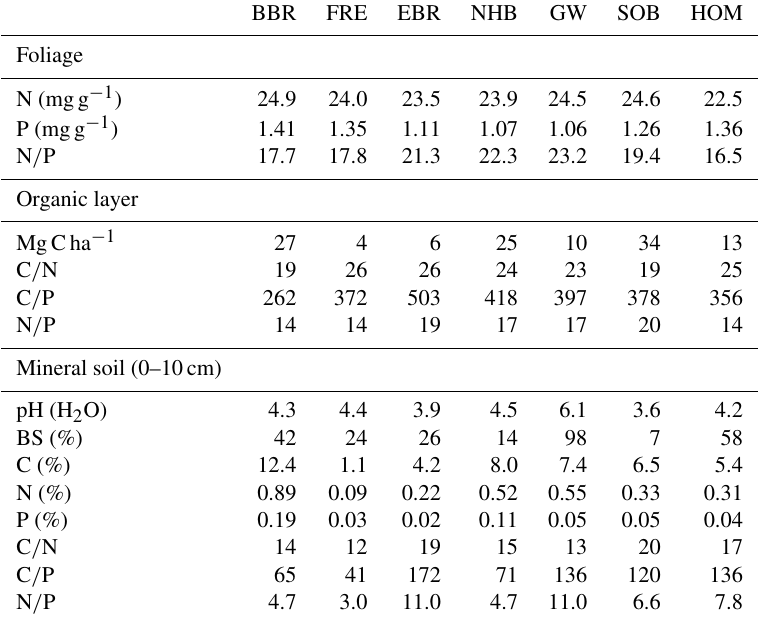
Table 2. Chemical characteristics of foliage, soil organic layer, and the upper mineral soil (0–10cm) of seven European beech ( Fagus sylvatica L.)